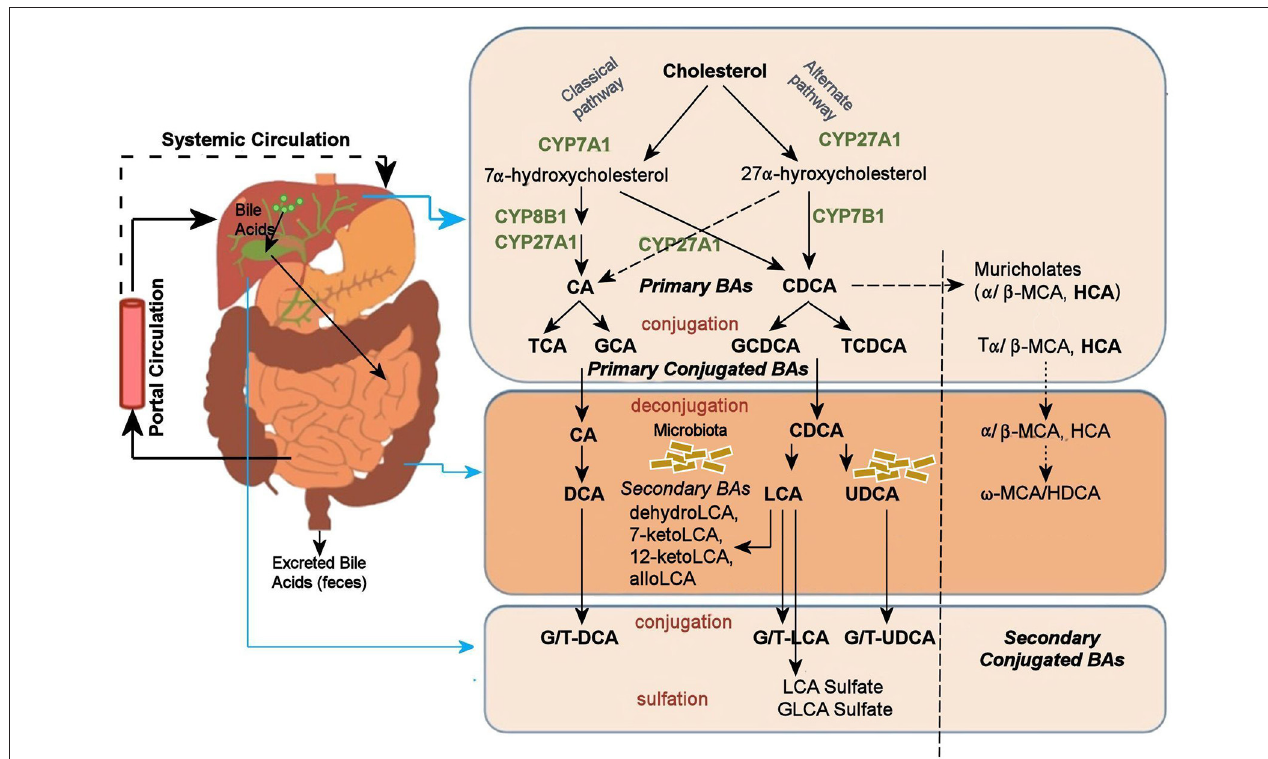
FIGURE 1 | Bile acid metabolism pathway. Bile acids are synthesized from cholesterol in the liver mainly by two pathways. The classical pathway is initiated by the rate-limiting enzyme, CYP7A1 that synthesizes the two primary bile acids in humans, CA and CDCA. CYP8B1 is required for CA synthesis along with the mitochondrial CYP27A1 that catalyzes a steroid side-chain oxidation. The alternative pathway is initiated by CYP27A1, followed by CYP7B1. After synthesis, the primary bile acids are conjugated to the amino acids taurine or glycine for biliary secretion. In the distal ileum and colon, gut bacteria deconjugates the conjugated bile acids, and bacterial 7 α -dehydroxylase removes the 7 α -hydroxyl group to convert CA and CDCA to the secondary bile acids DCA and LCA, respectively. The LCA as a high toxic bile acid is mostly excreted by feces. A small amount of LCA, which is recycled back into the liver, is subjected to sulfor conjugation at the 3–hydroxy position of sulfotransferase 2A1 (SULT2A1). Sulfoconjugated BAs are almost never reabsorbed by the most important transport proteins, and they are excreted from the body. Several other bacterial modifications are now known that result in the production of a no of different secondary BAs. The classical pathway is the major pathway for daily synthesis of about 80–90% of the bile acids in humans, whereas the alternative pathway synthesizes about 10–20%. Most bile acids ( ∼ 95%) are reabsorbed in the ileum and transported via portal blood to the liver to inhibit bile acid synthesis. A small amount of bile acids ( ∼ 5%) lost in feces is replenished by de novo synthesis. BA, Bile Acid; CA, Cholic Acid; CDCA, Chenodeoxycholic Acid; DCA, Deoxycholic Acid; FXR, Farnesoid X Receptor; GCA, Glycocholic Acid; GCDCA, Glycochenodeoxycholic Acid; GLCA, Glycolithocholic Acid; HCA, Hydroxycitric Acid; HDCA, Hyodeoxycholic Acid; LCA, Lithocholic Acid; MCA, Monocarboxylic